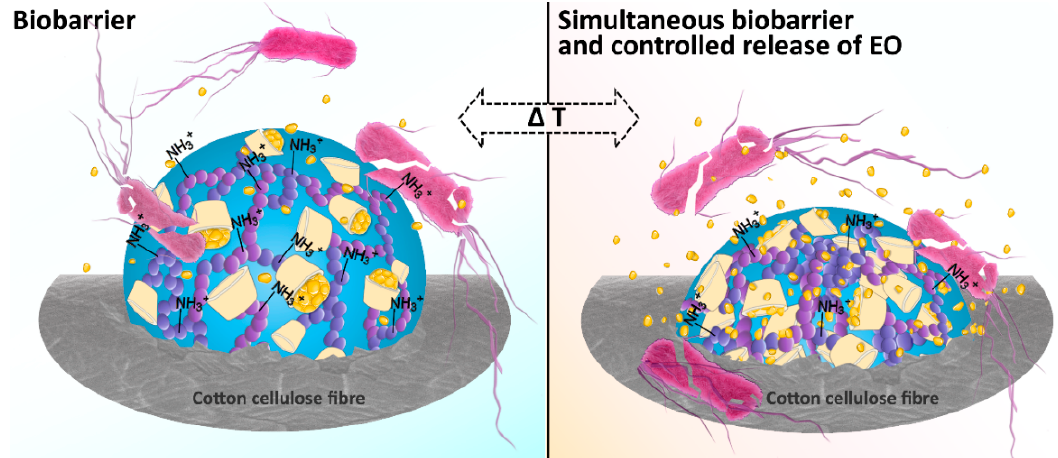
Figure 1. Proposed dual antimicrobial activity of the poly-( N -isopropylacrylamide) (poly-NiPAAm)/chitosan based hydrogel (PNCS/CD) hydrogel in correlation with the changes in temperature of the environment .